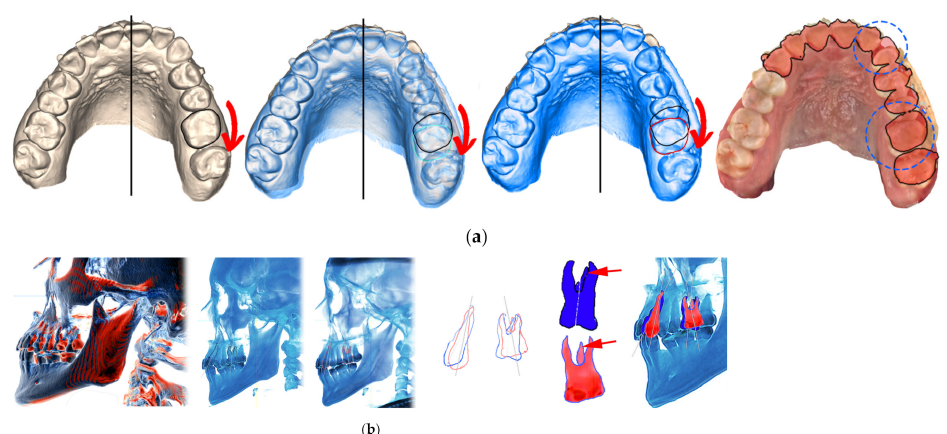
Figure 18. Result of distalization of teeth segments 23–27 with a 3D printed distalizer. ( a ) intraoral scan of one of the results with teeth positions before and after distalization phase. Distorotation of the crown of 26 is shown with a red arrow with an occlusal 2.5–3.0 mm effect circled in blue; ( b ) comparison of original and new (red) CBCT with a visible distal position of teeth in the 2nd quadrant, the second picture is CBCT before treatment, the third picture CBCT after distalization phase followed by contours of teeth 23 and 26 from CBCT, where blue is before and the red contour is a new distalized